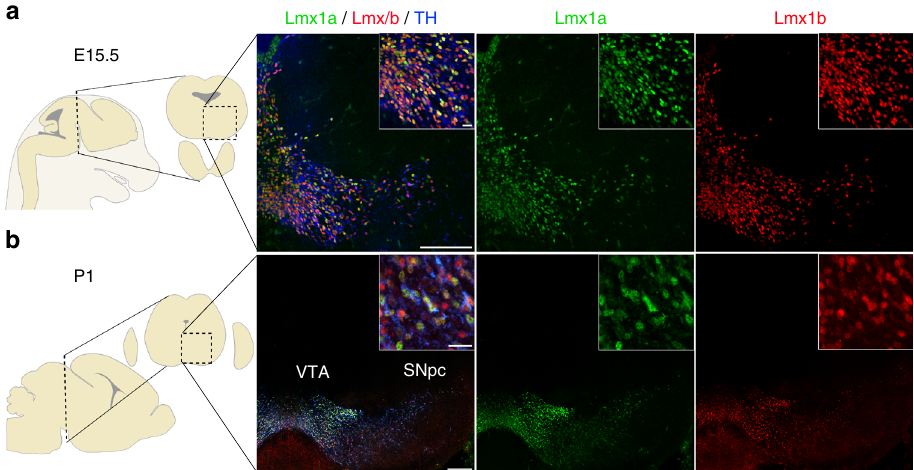
Fig. 1 Ventral midbrain expression of transcription factors Lmx1a and Lmx1b at early stage of development. Representative confocal stitched images of immunohistochemical staining of the transcription factors Lmx1a and Lmx1b in TH-positive neurons in midbrain coronal sections at E15.5 ( a ) and P1 ( b ). Although Lmx1a and Lmx1b are present in all mDA neurons, the staining intensity for Lmx1a and Lmx1b varies in mDA neurons. Scale bars: a , 200 µ m and 10 µ m for high-magni fi cation inserts; b , 200 µ m, and 20 µ m for high-magni fi cation inserts. SNpc, substantia nigra pars compacta; VTA, ventral